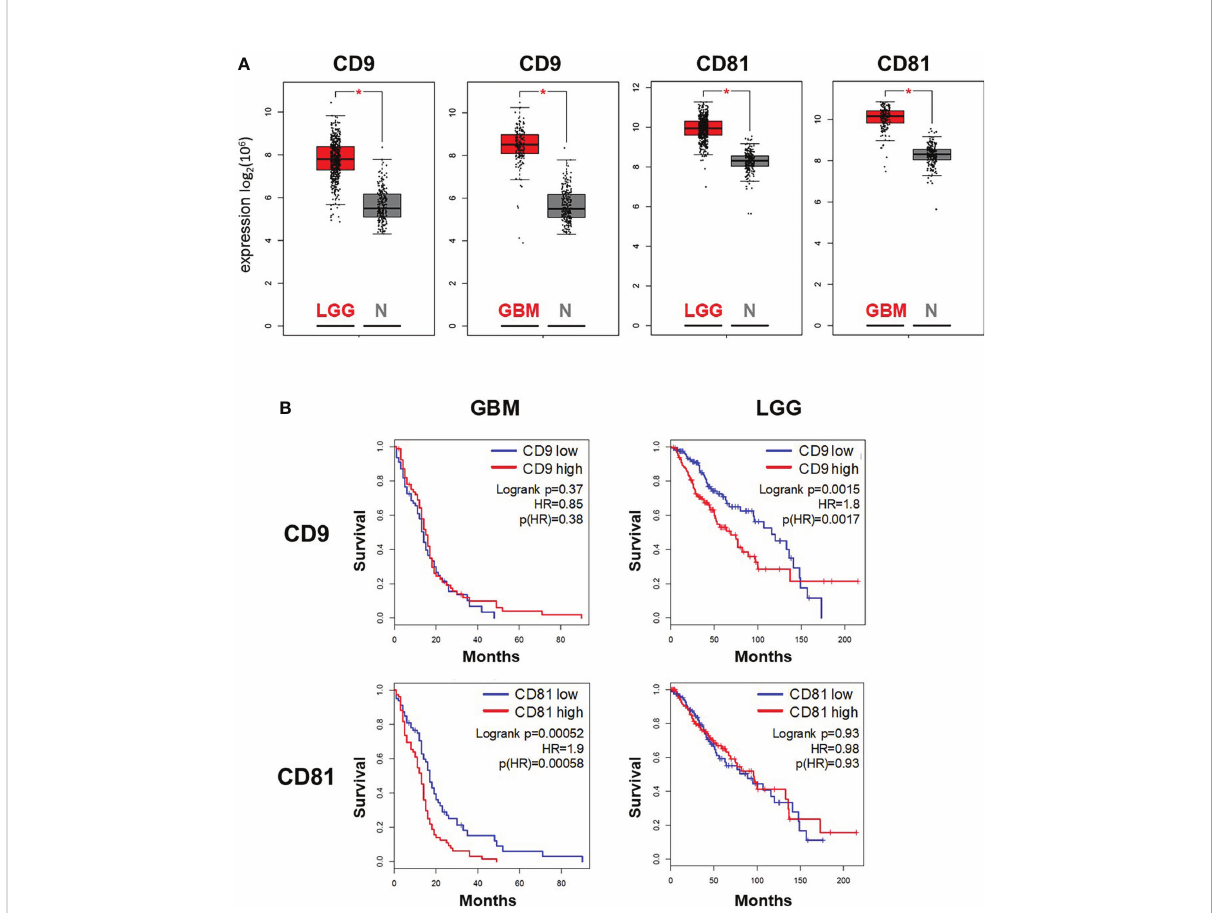
FIGURE 3 Expression of the tetraspanins CD9 and CD81 in glioma tumor samples correlates with survival of patients with glioma and glioblastoma. Expression (A) and survival analysis (B) of patients with glioblastoma multiforme (GBM) and low-grade glioma (LGG) were performed using data accessible at the GEPIA platform (http://gepia.cancer-pku.cn/). (A) Box plot analysis of CD9 and CD81 expression in GBM (n = 163) and LGG tissue (n = 518) in comparison to in non-malignant brain tissue (normal tissue N, n = 207)). * indicates signi fi cance (p < 0.05). (B) High expression of CD9 correlated with shorter survival in patients with LGG, while high expression of CD81 correlated with shorter survival in patients with